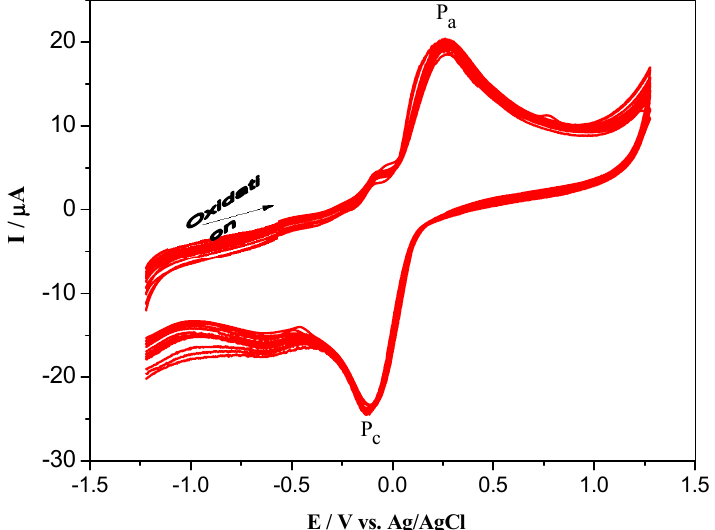
Figure 5. CVs of 3.33 mM of Nq in 0.10 M of PBS (pH 7.0) at the GCE with a scan rate of 100 mV/s.